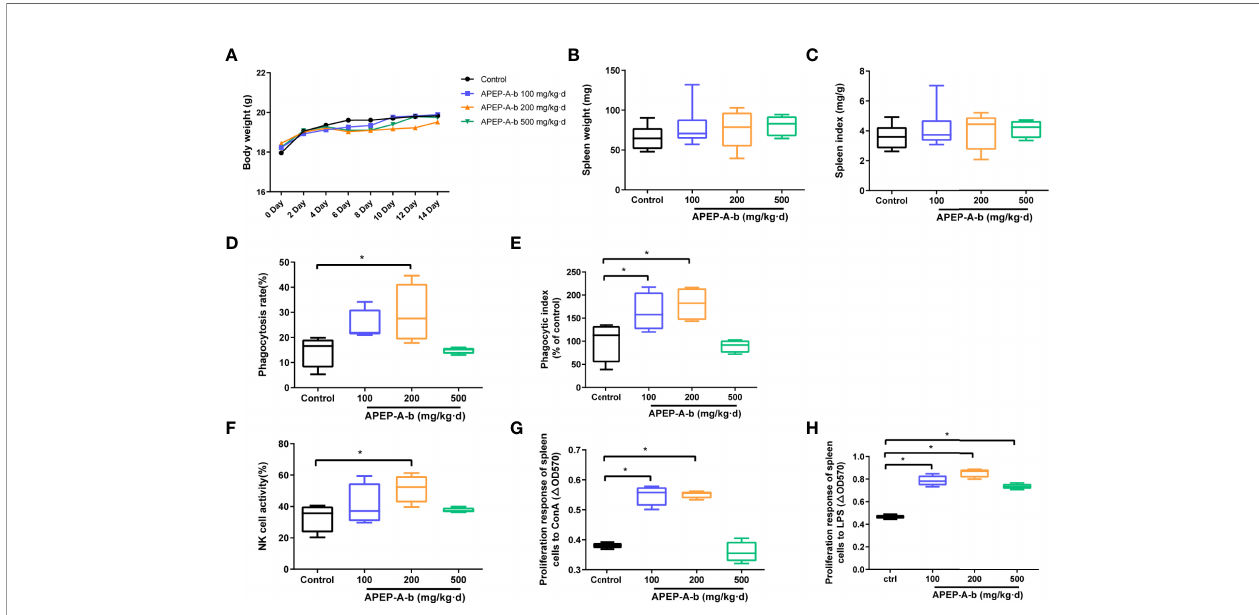
FIGURE 2 | APEP-A-b enhanced immune response in mice. Effects of the APEP-A-b on body weight (A) , spleen weight (B) and spleen index (C) , phagocytosis capacity of peritoneal cavity phagocytes (D, E) , NK cell activity (F) , ConA-stimulated T cell proliferation (G) , LPS-stimulated B cell proliferation (H) . Data are represented as the means ± SD (n = 6). * P < 0.05, compared with the Control